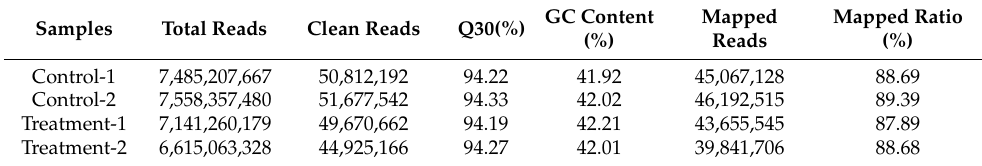
Table 2. Aligning statistics of clean reads with assembled unigenes.